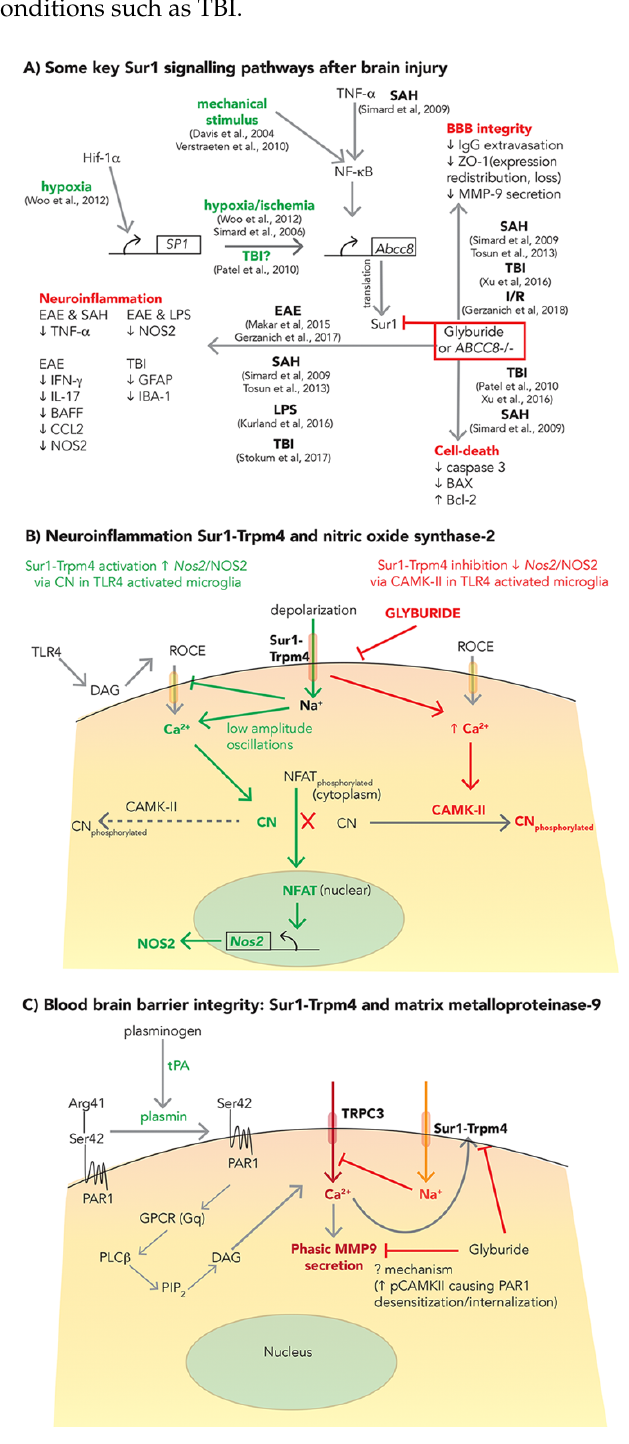
Figure 2. Putative SUR1 molecular signaling pathways beyond cerebral edema in brain injury. ( A ) Some key Sur1 signaling pathways after brain injury. This schematic illustrates upstream regulators of Sur1 ( Abcc8 ) transcription such as Hif1- α , SP1 and TNF- α . The precipitating injury (e.g., hypoxia, TBI, mechanical stimulus) is listed in green. Downstream consequences of inhibiting upregulated